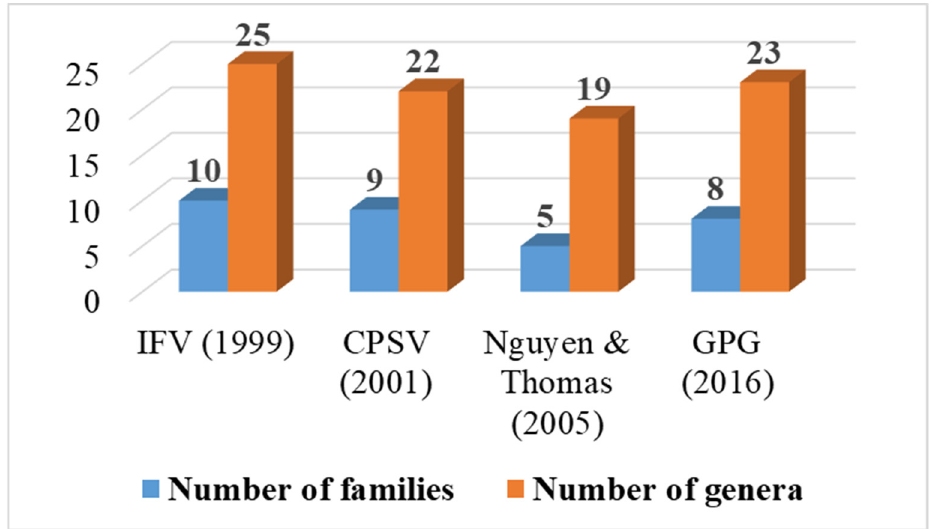
Figure 2. Number of families and genera of gymnosperms in Vietnam according to different treat- ments.